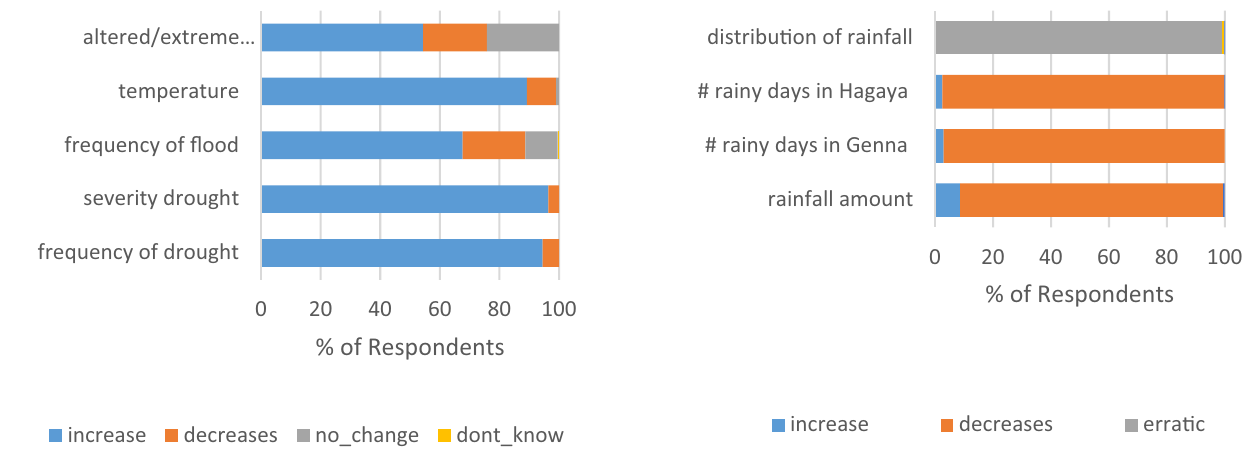
Figure 5. Respondent perceptions on climate variabilities and change